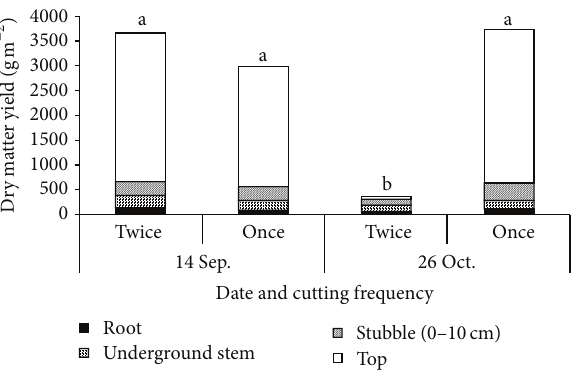
Figure 2: Changes in DM yield of Napiergrass after a single cutting (once) and after two cuttings (twice). Figures with the same letter were not significantly different at 𝑃 < 0.05 based on LSD test.